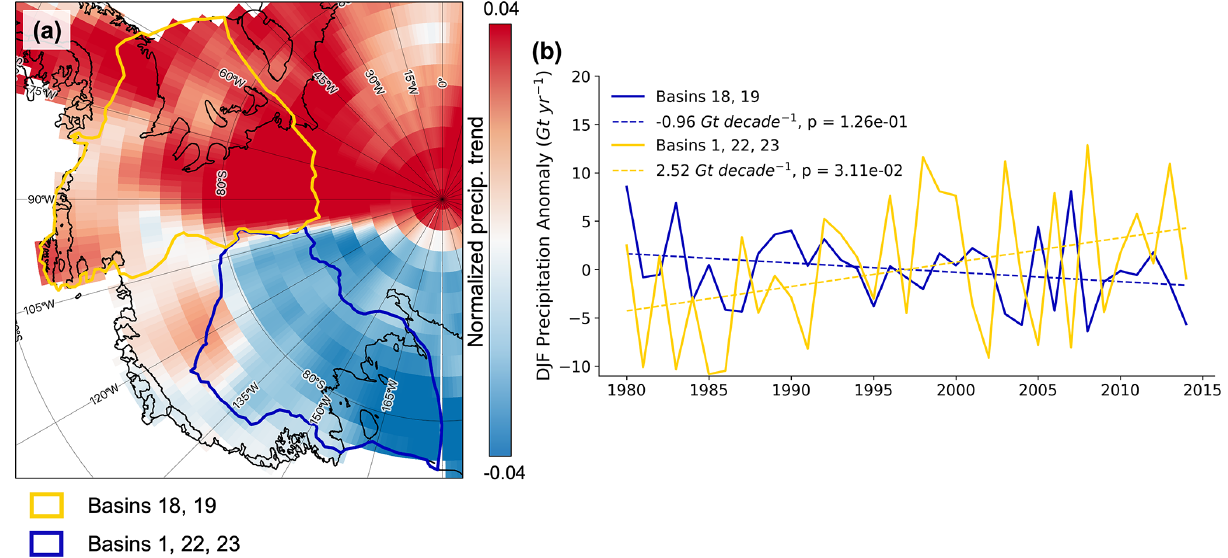
Figure A7. (a) Normalized 1979–2015 DJF trend in total precipitation from CESM2 with basins 18 and 19 outlined in blue and basins 1, 22, and 23 outlined in yellow. (b) Time series of the yearly DJF precipitation anomaly with trend lines for areas outlined in (a) .